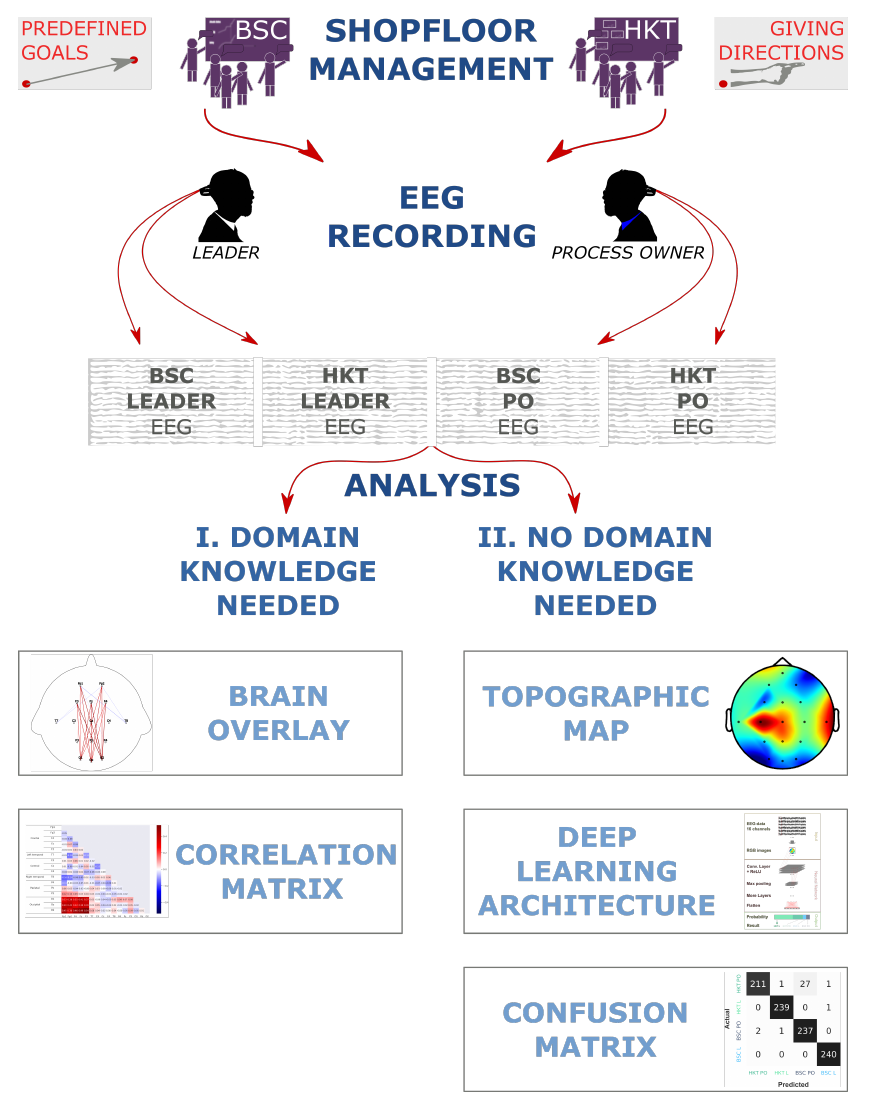
Figure 1. Graphical